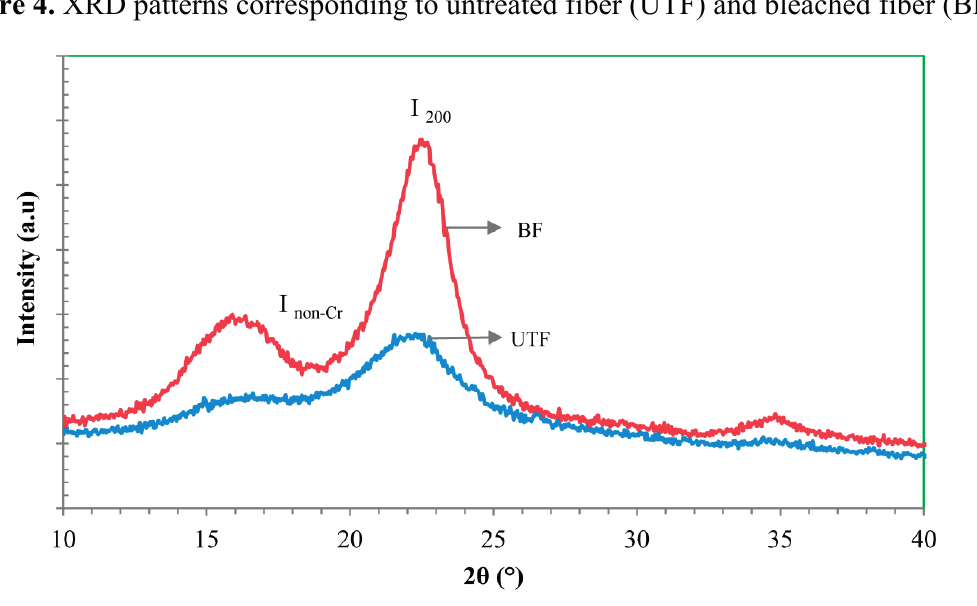
Figure 4. XRD patterns corresponding to untreated fiber (UTF) and bleached fiber